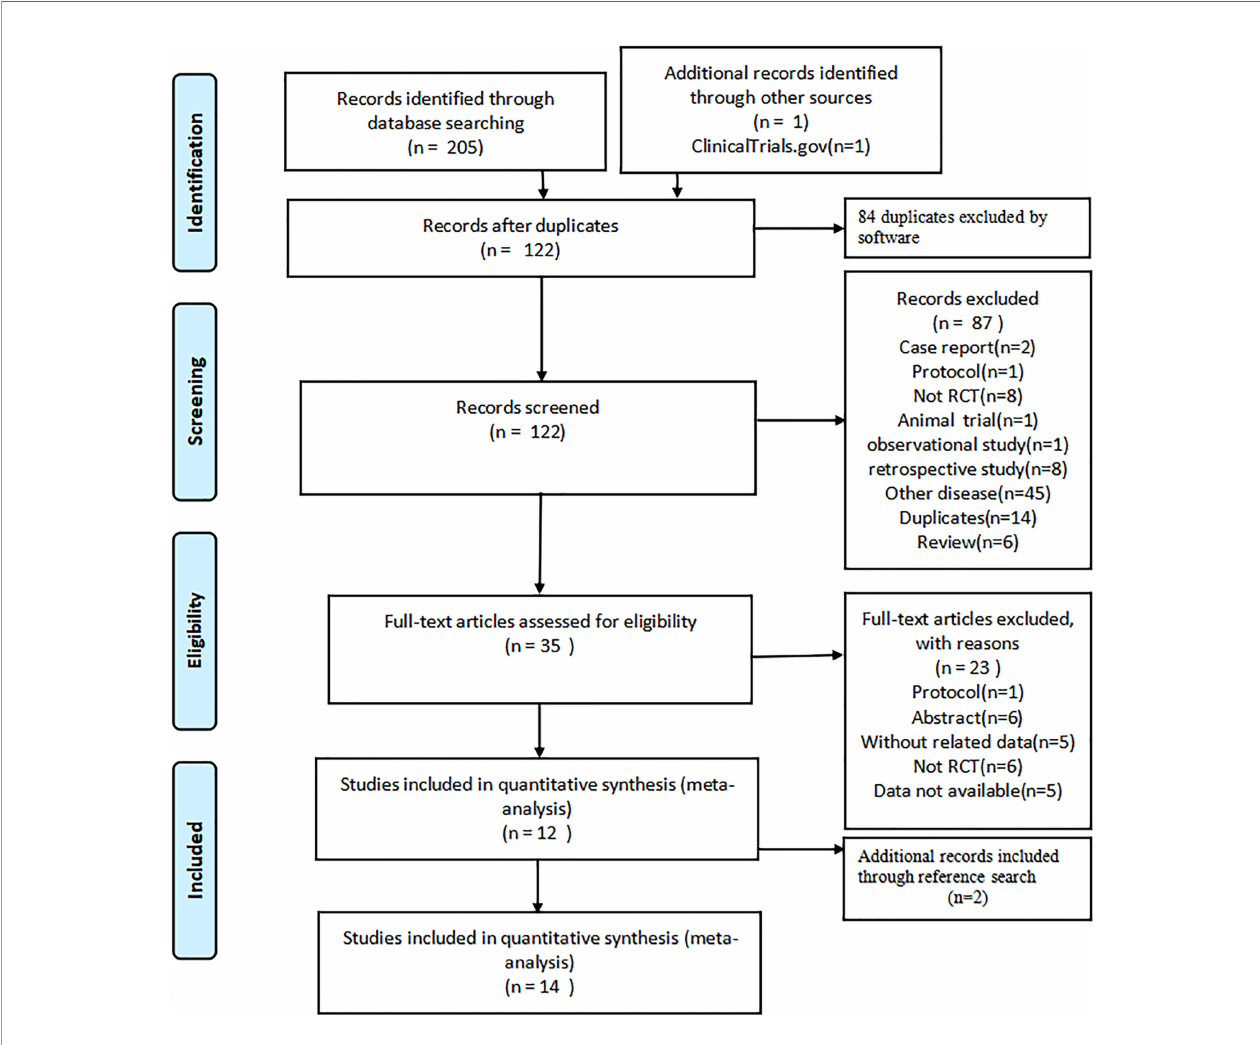
FIGURE 1 | The fl owchart of the study selection